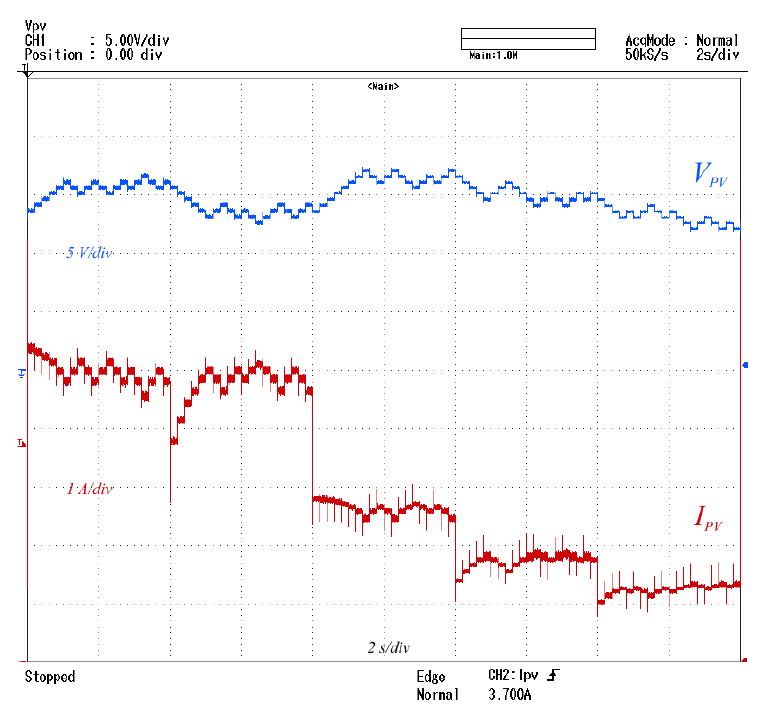
Figure 11. PV module voltage and current ( V pv and I pv , respectively) for five different temperature and irradiance conditions, when the P&O algorithm is implemented in the SICIBB